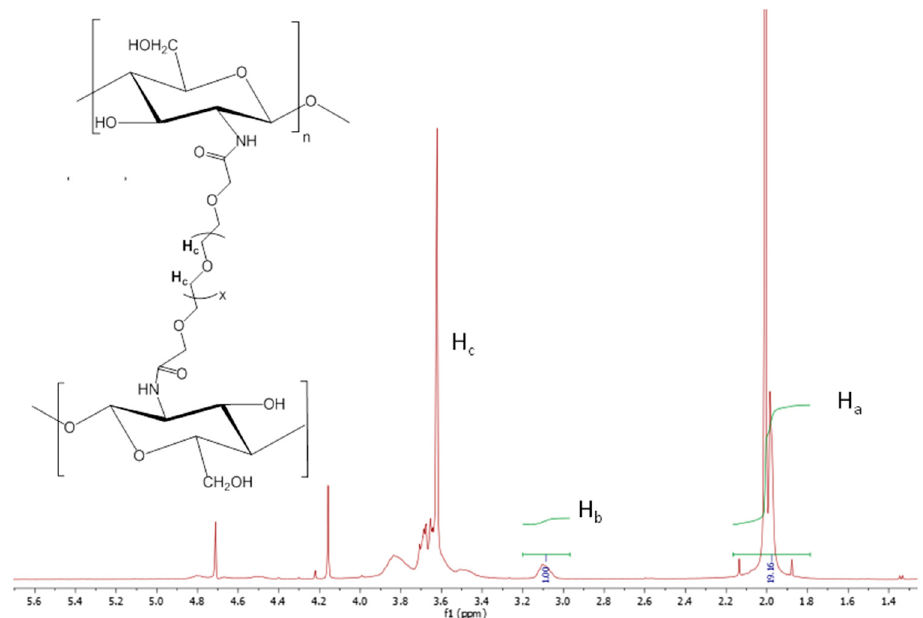
Figure 4. 1 HNMR spectrum of the low molecular weight chitosan nanogels obtained by the amidation reaction with PEGBCOOH in the reverse microemulsion.